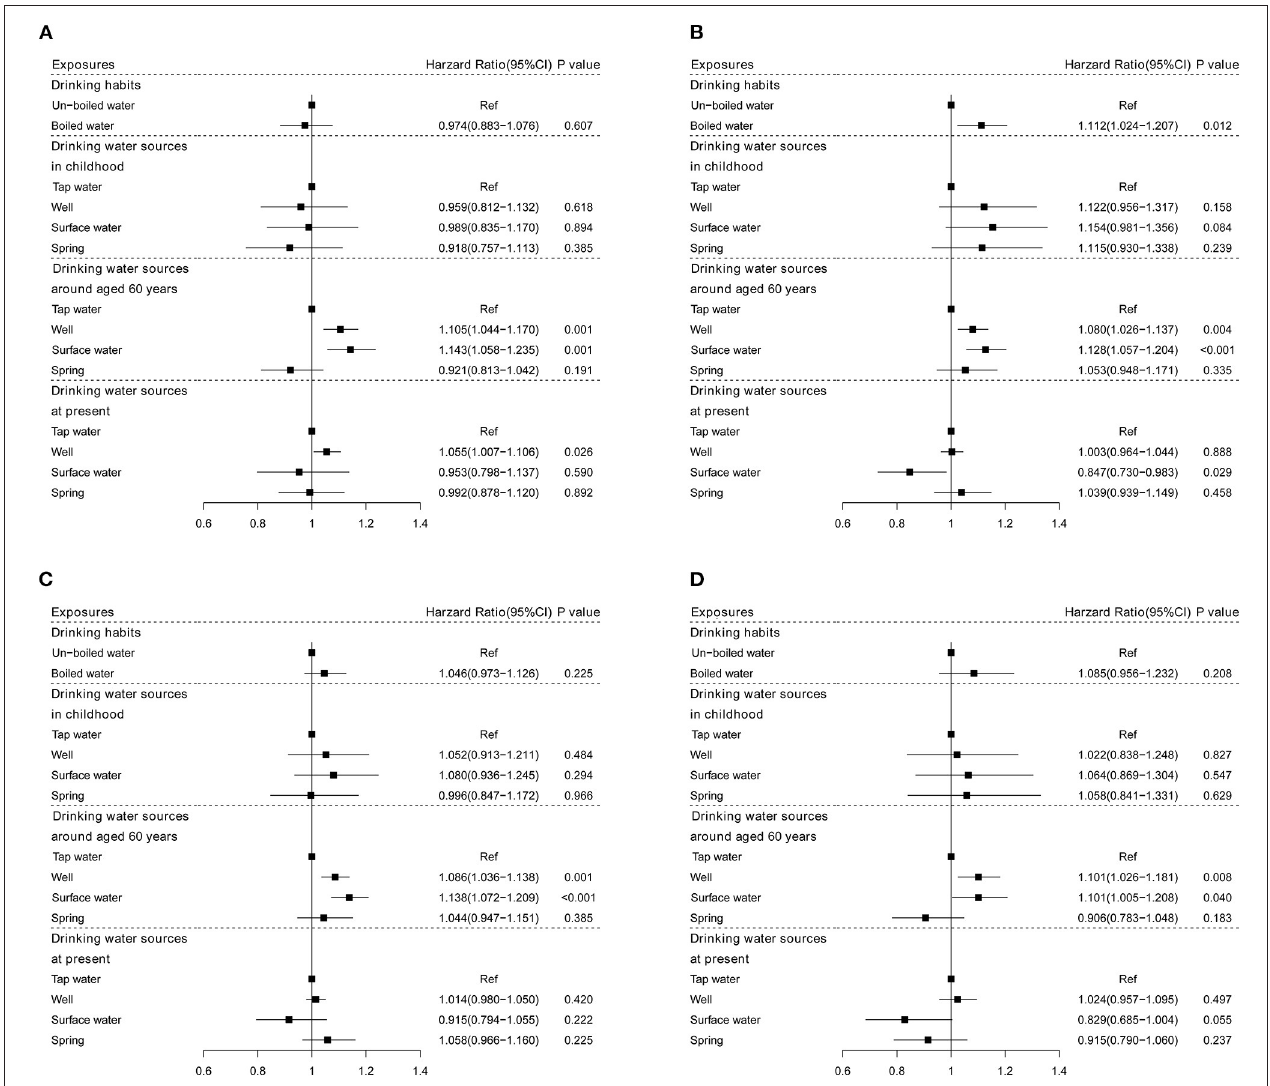
FIGURE 2 | The associations of drinking water sources and habits with all-cause mortality stratified by sex and living areas. (A) Males; (B) females; (C) urban; and (D)